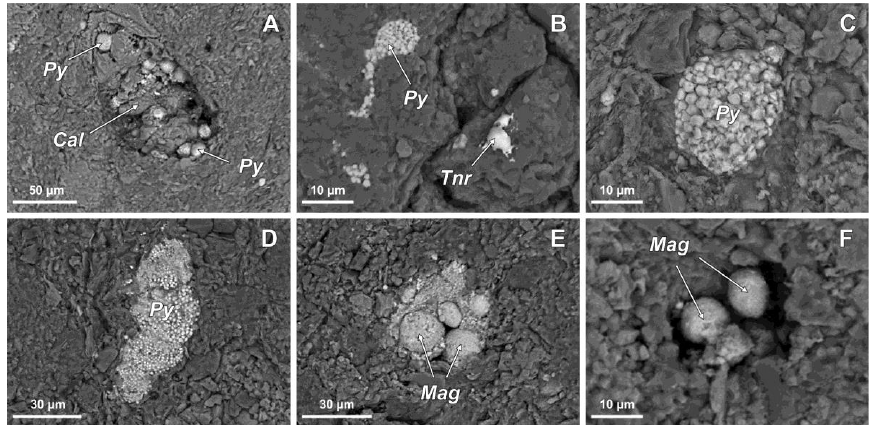
Figure 3. Framboidal Fe sulfide and oxide in Priorat black shale. ( A ) Development of discrete grains of framboidal pyrite within textural void filled with subhedral calcite crystals. ( B ) Framboidal pyrite in association with tenorite (CuO). ( C ) Single framboid composed of truncated-cubic and octahedral pyrite microcrystals. ( D ) Cluster (>60 µm) of densely spheroidal pyrite microcrystals (each ~1 – 2 µm across). ( E ) Individual spheroidal magnetite crystals. ( F ) Spherodial magnetite crystals in a void in black shale. Py — pyrite, Mag — magnetite, Cal — calcite, Tnr — tenorite. All mineral abbreviations in Figures 3 – 7 are derived from [42].